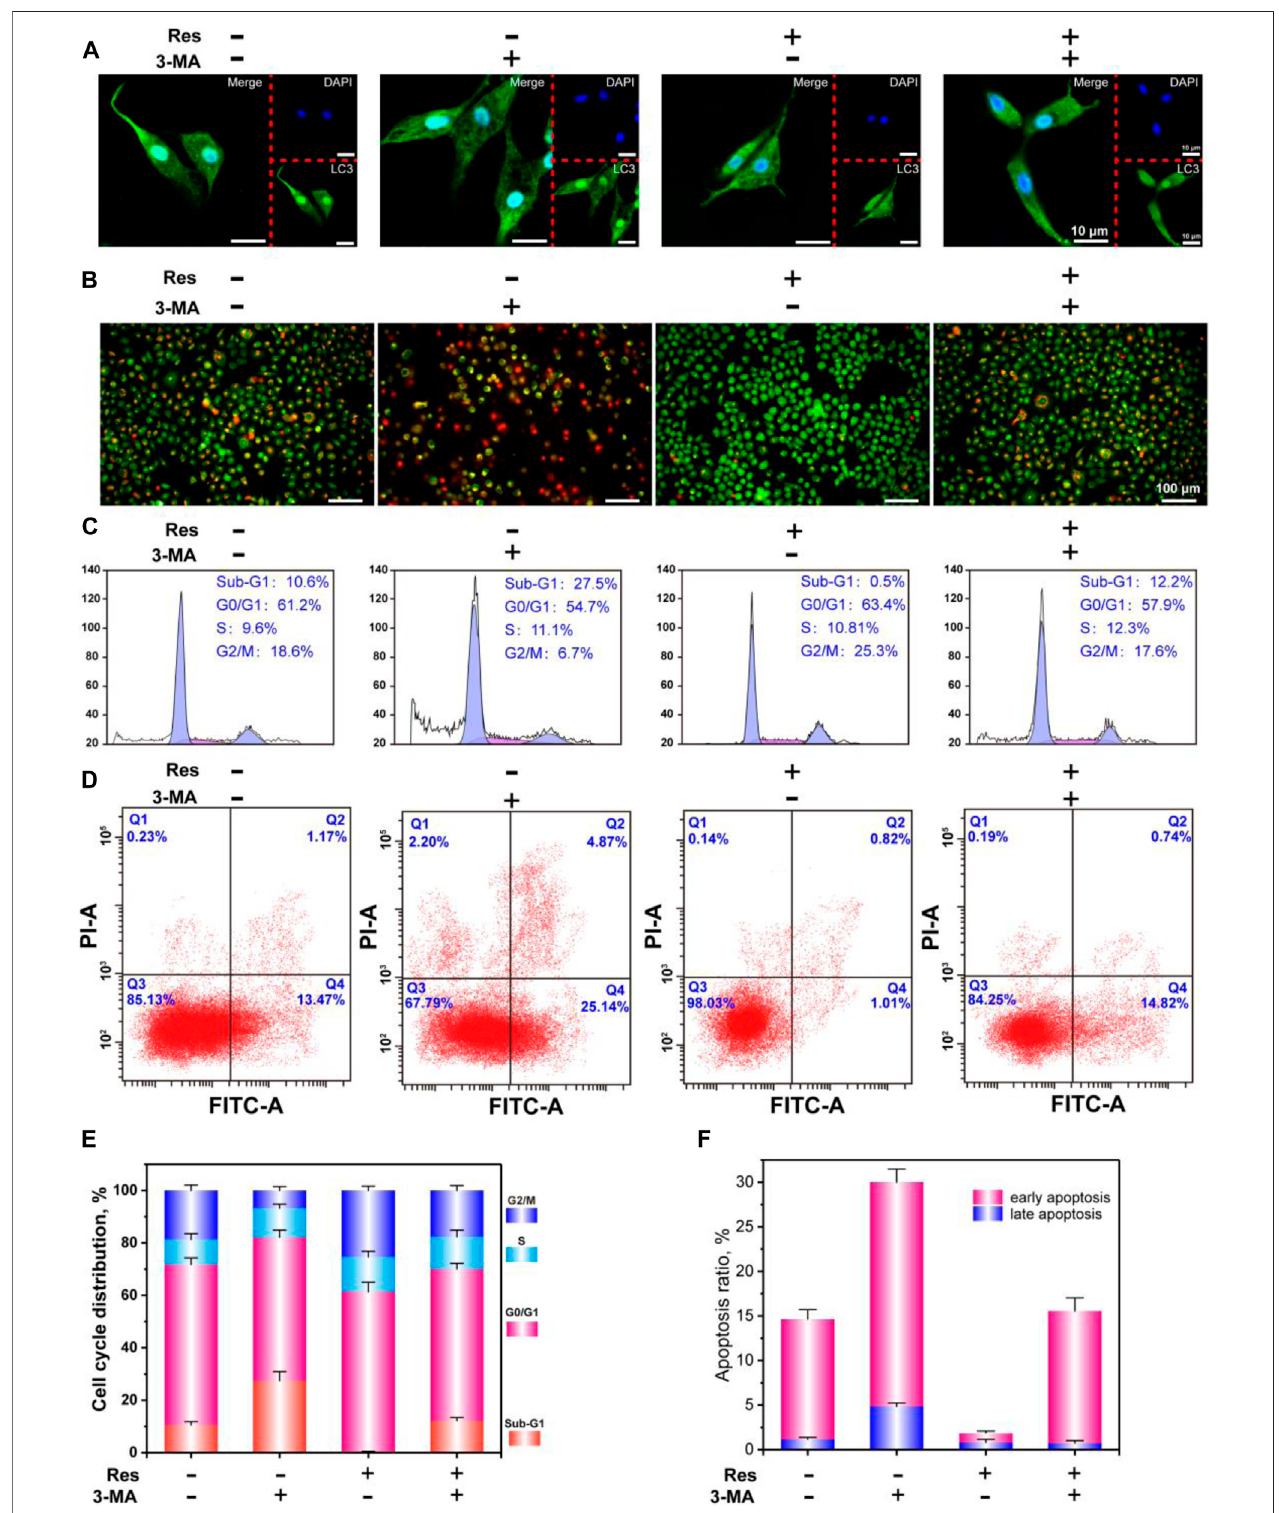
FIGURE 3 | Osteogenic differentiation of BMSCs treated with Res and 3-MA for 14 days. ALP activity detection (A) and ARS staining (B) . mRNA expression of Runx2 (C) and OPN (D) detected by q-PCR. The quantative data ofCa nodulus analyzed by ARS stainingusing imageJ software (E) . The values are represented as the mean ± SD ( n (cid:1) 3). * p < 0.05, ** p < 0.01 vs control (without Res and 3-MA); # p < 0.05, ## p < 0.01 vs Res group.